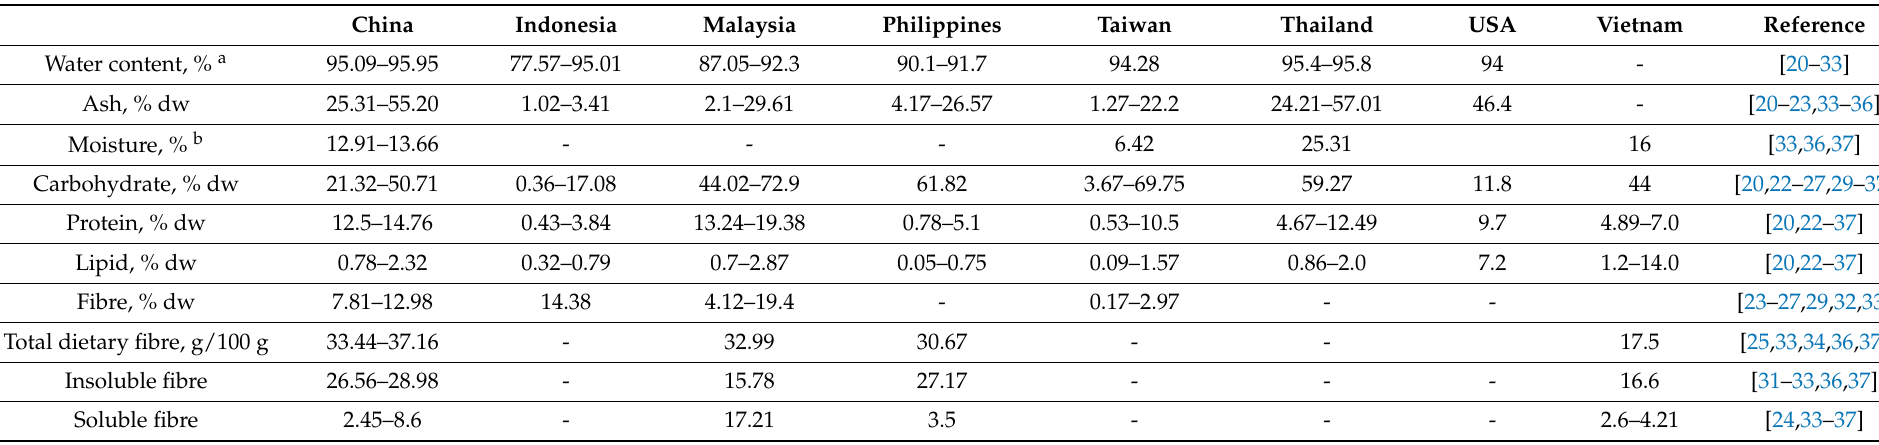
Table 2. Proximate composition and fibre contents of C. lentillifera from different